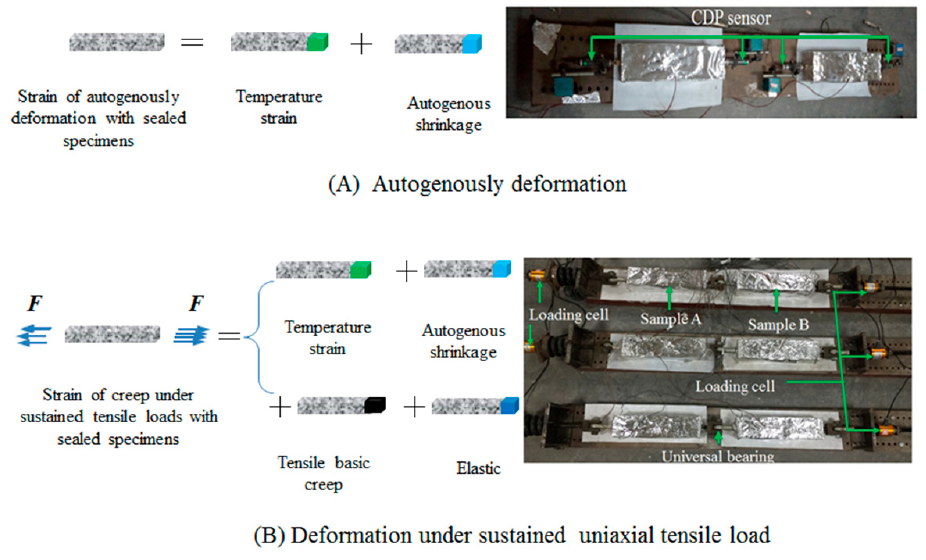
Figure 3. Experimental principle and physical picture of tensile creep strain divided.